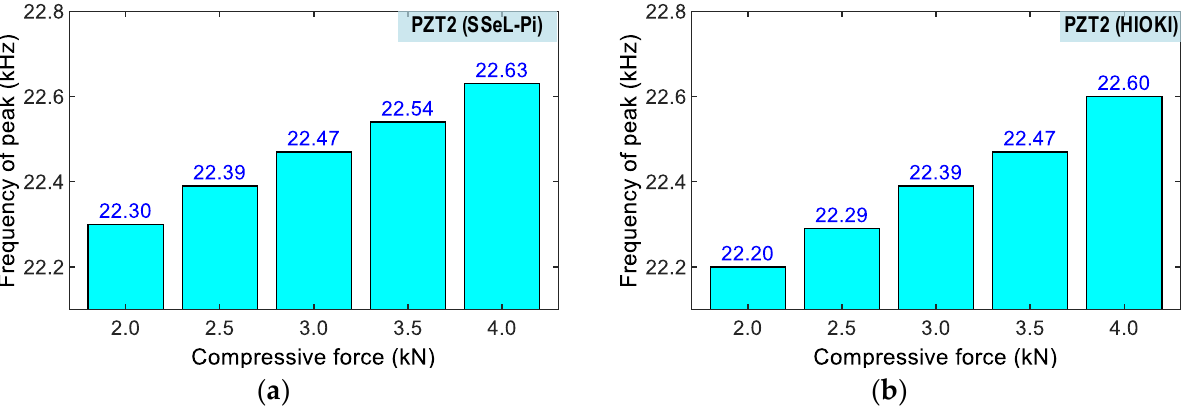
Figure 22. Frequency shifts of PZT 2 corresponding to compressive loadings P1 – P5. ( a ) SSeL-Pi, ( b ) HIOKI-3532.